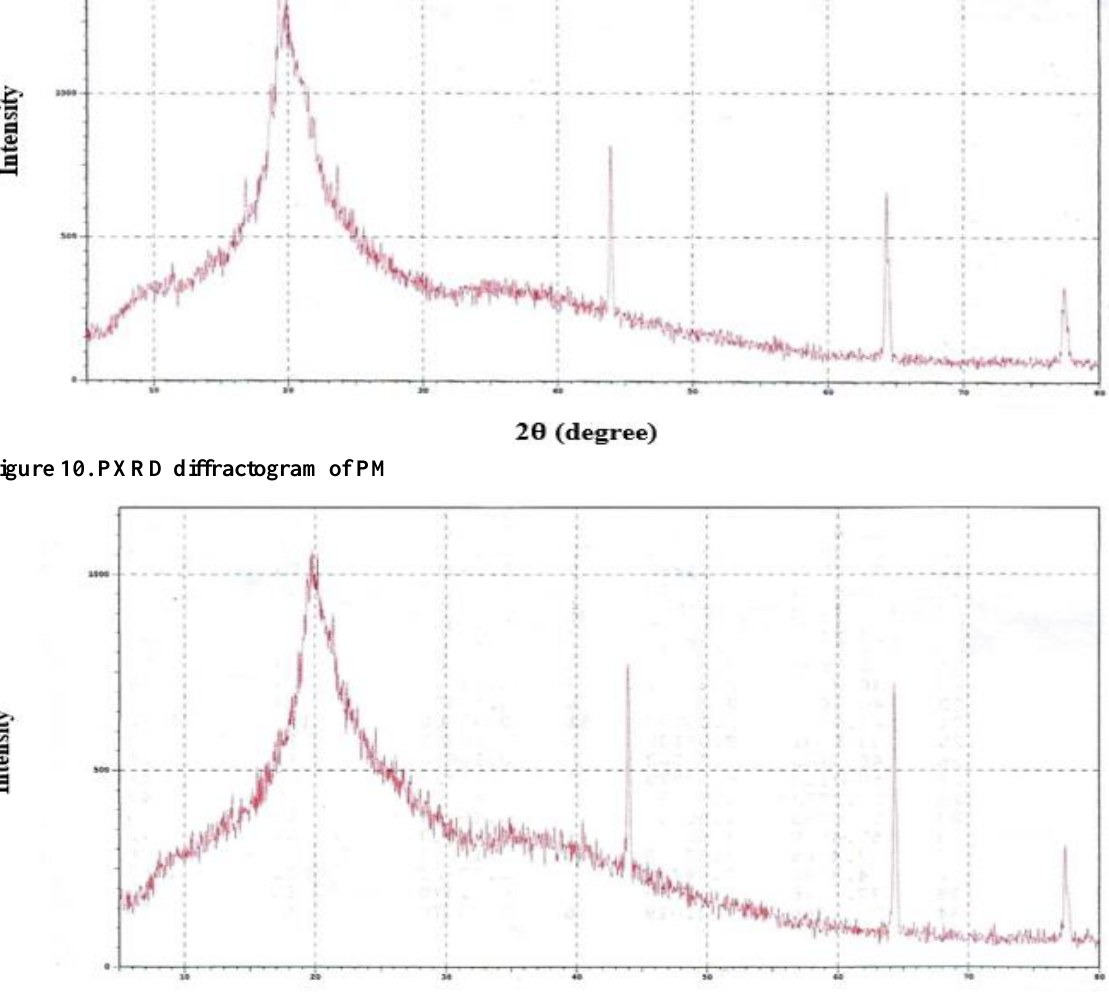
Figure 11. PXRD diffractogram of